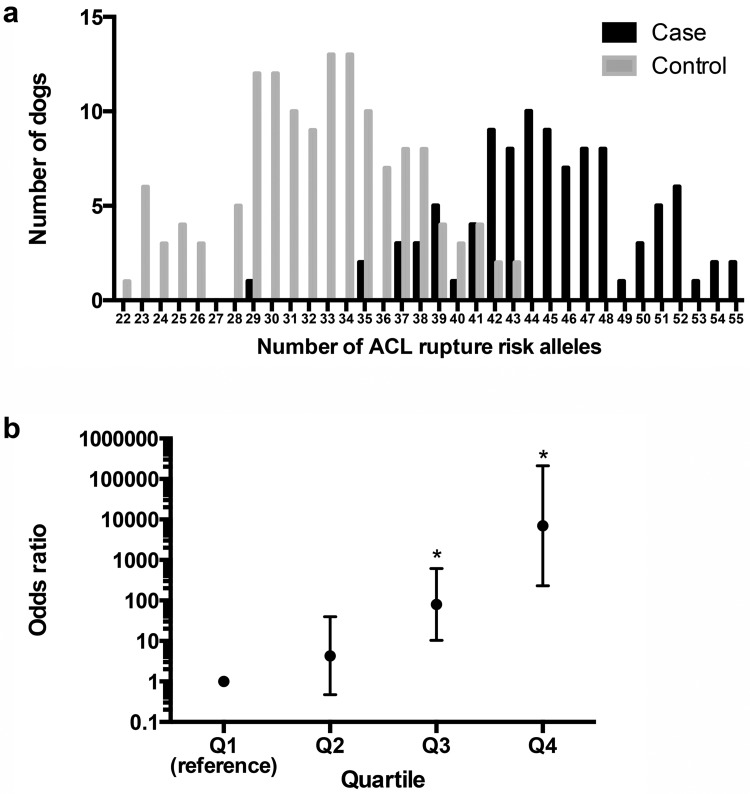
Genetic risk scoring [42] using GWAS associated loci from linear mixed model analysis with GEMMA segregates ACL rupture disease risk in case and control Labrador Retriever dogs.(a) Distribution of the number of ACL rupture risk loci in case and control groups of Labrador Retriever dogs. The number of risk alleles in cases and controls is significantly different (P<2.2E-16) (b) ACL rupture odds ratios of weighted genetic risk scores (wGRS) relative to the first quartile. Vertical bars represent the 95% confidence intervals. * Odds ratio is significantly different from the reference first quartile.